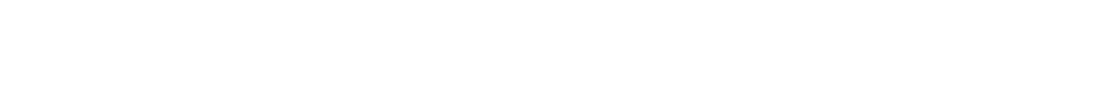
FIGURE 2 | Domain configuration of the KIRs. The extracellular Ig-like domain is classified into three types, D0, D1, and D2, dependent on the sequence homology. KIR2DL4 possesses an ITIM motif, but also associates with the FcR γ